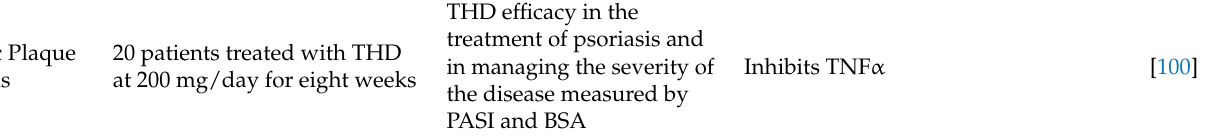
Table 1. Thalidomide mechanism of action in vivo.